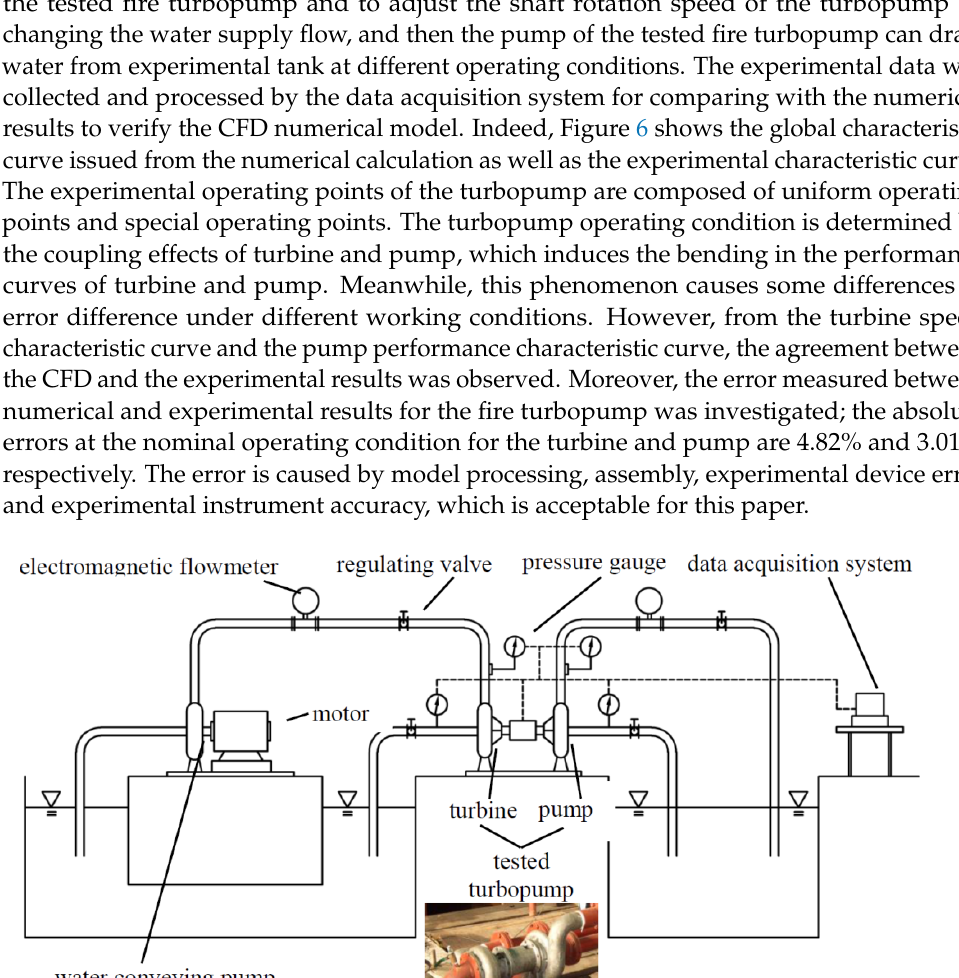
Table 2. Boundary conditions used in the numerical simulation [21,22].